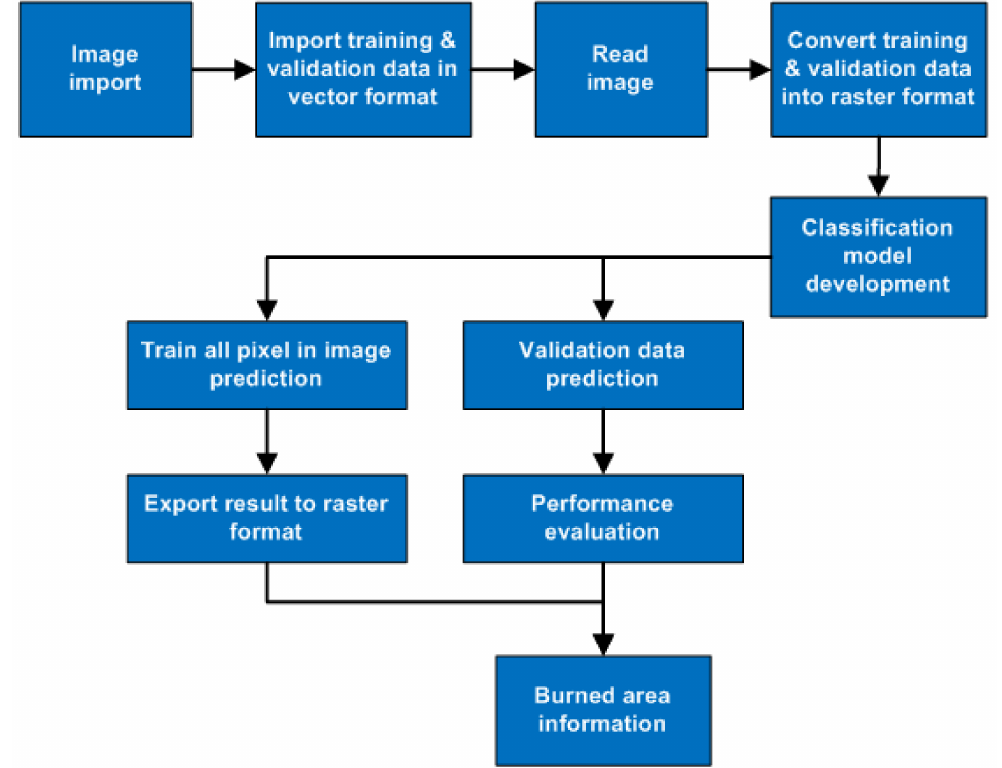
Figure 8. Classification